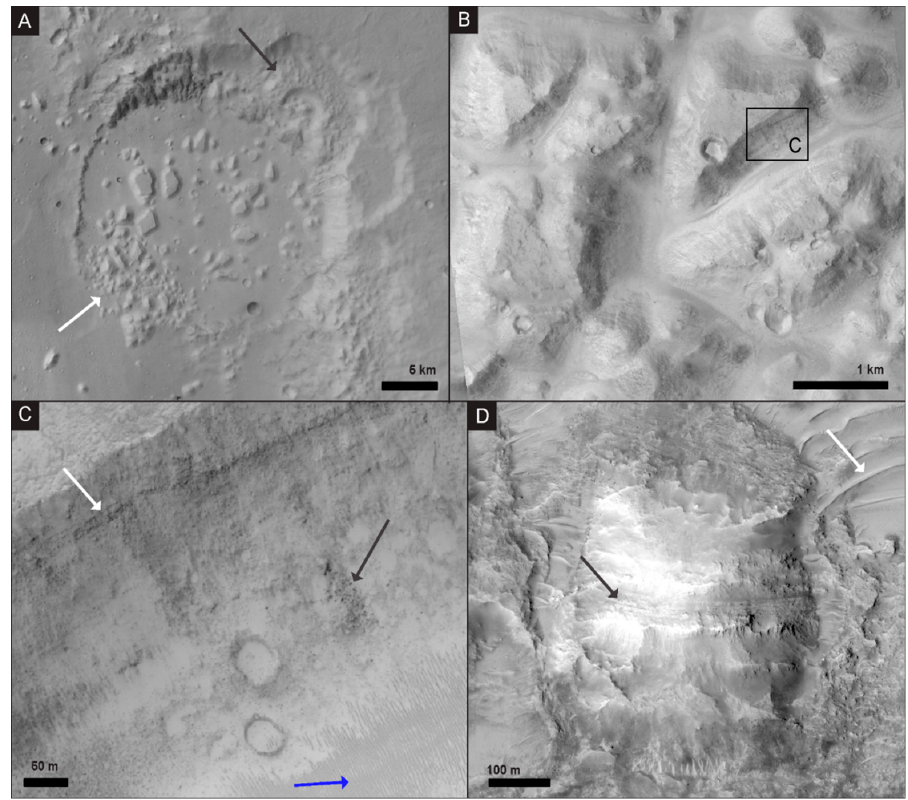
Figure 6. Chaos terrain in Galilaei crater. ( A ) A 23 km diameter crater interrupts the rim of Galilaei crater and is itself filled with chaos terrain blocks. The northwest of the smaller crater rim (black arrow) is particularly eroded and is potentially a source for blocks that were transported to the southwest. The southwestern rim of the crater (white arrow) may have provided a topographic barrier that prevented the blocks from sliding further, as supported by the cluster of blocks inside the crater at this point and the absence of blocks exterior to this crater rim. ( B ) The typical block and mound morphology of chaos terrain in Galilaei crater. The location of (C) is boxed. ( C ) The wall of a chaos block shows superimposed boulders (black arrow) and a resistant layer (white arrow) near the surface of the flat-topped block. Modern aeolian bedforms occupy the base of the valley (blue arrow). ( B , C ) are from HiRISE image ESP_033088_1850. ( D ) A mound in the chaos terrain shows sub-vertically exposed layering (black arrow), suggesting the block was tilted during transport. Modern aeolian bedforms (white arrow) again occupy topographic lows. HiRISE image ESP_068377_1855. In addition, southeast of Tana Vallis is a shallower channel that cuts across the